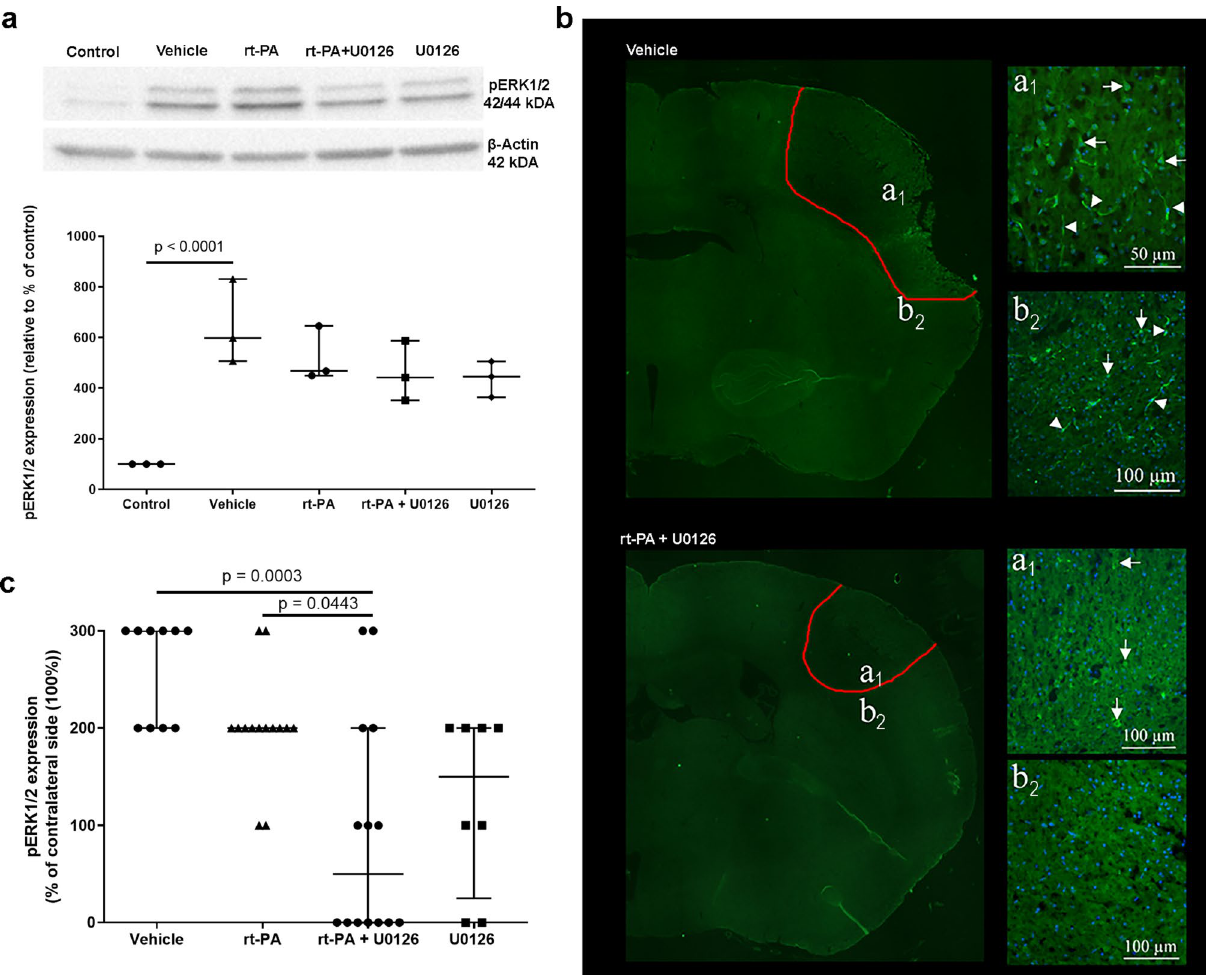
Figure 5. ( a ) p-ERK1/2 protein expression is shown by representative western blots and scatter plots. The protein expression of p-ERK1/2 was normalized to β-actin (loading control). In all comparisons, the average value for the control group was set to 100%. p-ERK1/2 has a molecular weight of 42/44 kDa and the one of β-actin is 43 kDa. Data are presented as median ± IQR, *P < 0.05 is considered statistically significant. ( b ) Representative image of pERK1/2 immunoreactivity. Upper panel, saline treated animal. To the left, area of stroke (outlined in red) is illustrated in a large image. Letters a 1 and b 2 refer to the illustrations to the right. a 1 . The stroke core is shown. Arrows point at pERK1/2 immunoreactive cells and arrow heads at vessels. b 2 . Immunoreactive cells and vessels were also found close to the stroke area. Lower panel, t-PA + U0126 treated animal. To the left, red-outlined stroke areas is illustrated in a large image. Letters a 1 and b 2 refer to the illustrations to the right. a 1 . Some pERK1/2 immunoreactive cells (arrows) were found in the stroke core, but not in the area outside the stroke b 2 . ( c ) Scatter plot showing semi-quantification of protein expression for pERK1/2. Data are presented as median ± IQR, and normalized to the non-occluded side. *P <